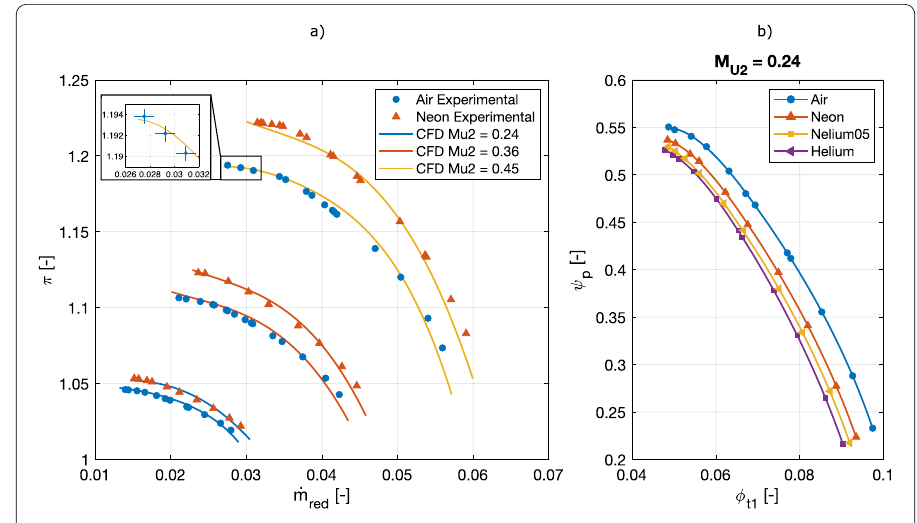
Figure 8 ( a ) Comparison of the experimental and numerical compressor performance map for the case of air and neon operation and ( b ) experimentally acquired pressure coefficient distribution for air, neon,